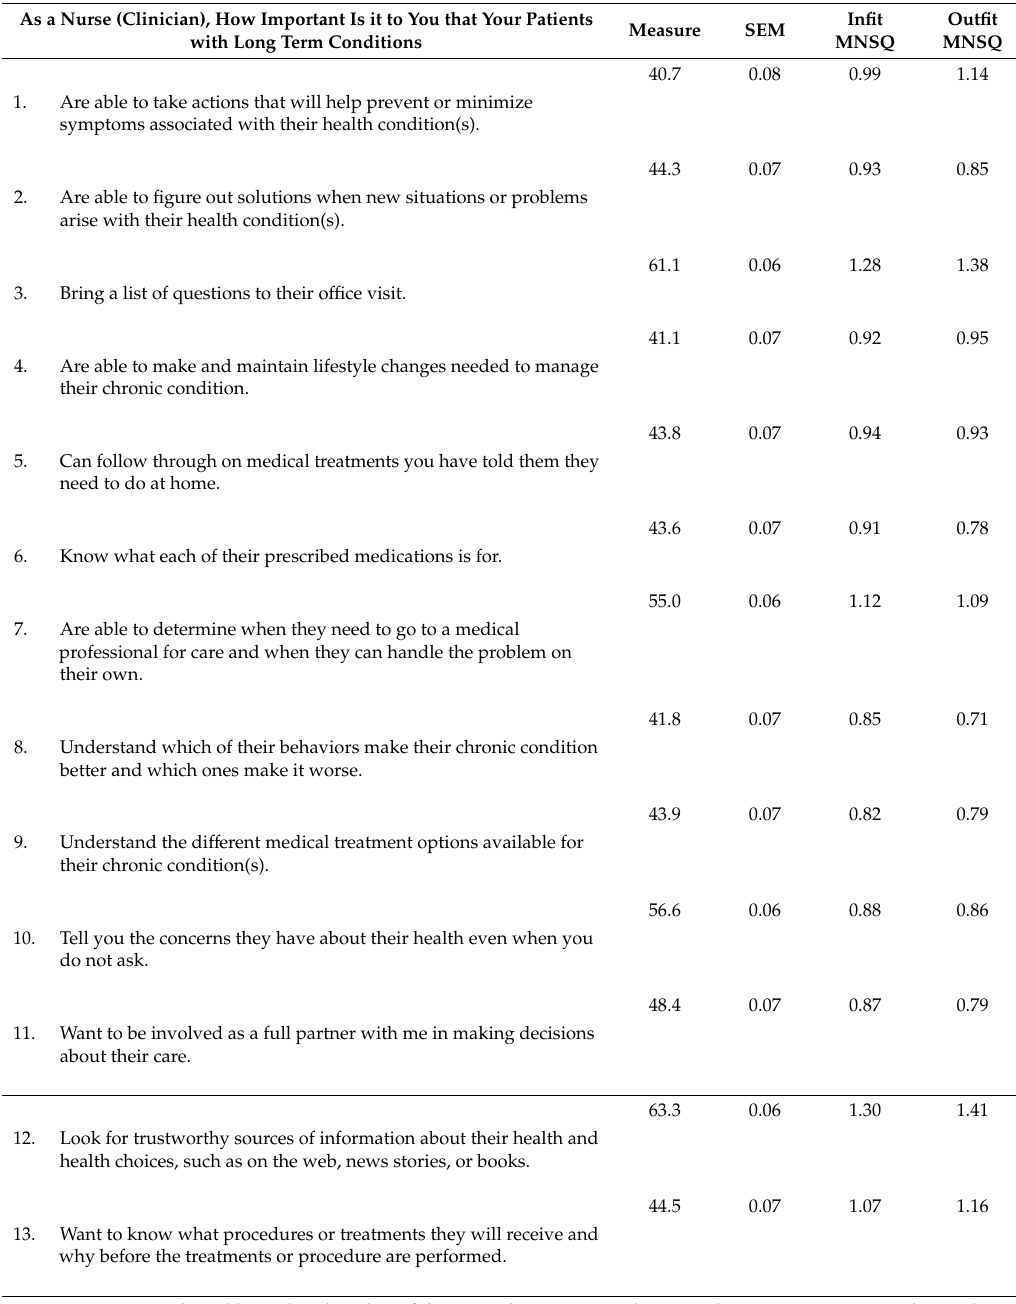
Table 2. Item calibration and the infit and outfit statistics for each item in the Korean CS-PAM.